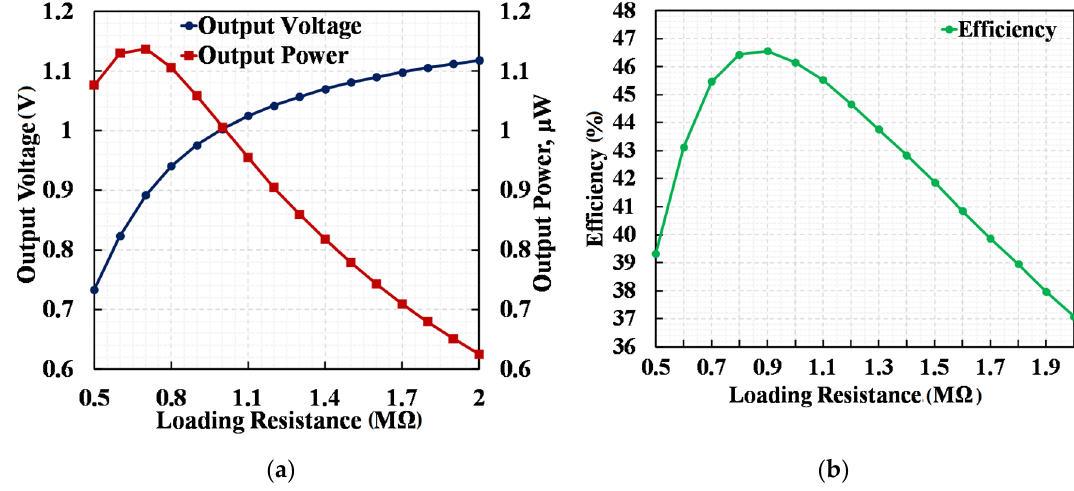
= 0.2 V; ( b ) measured e ffi ciency versus R